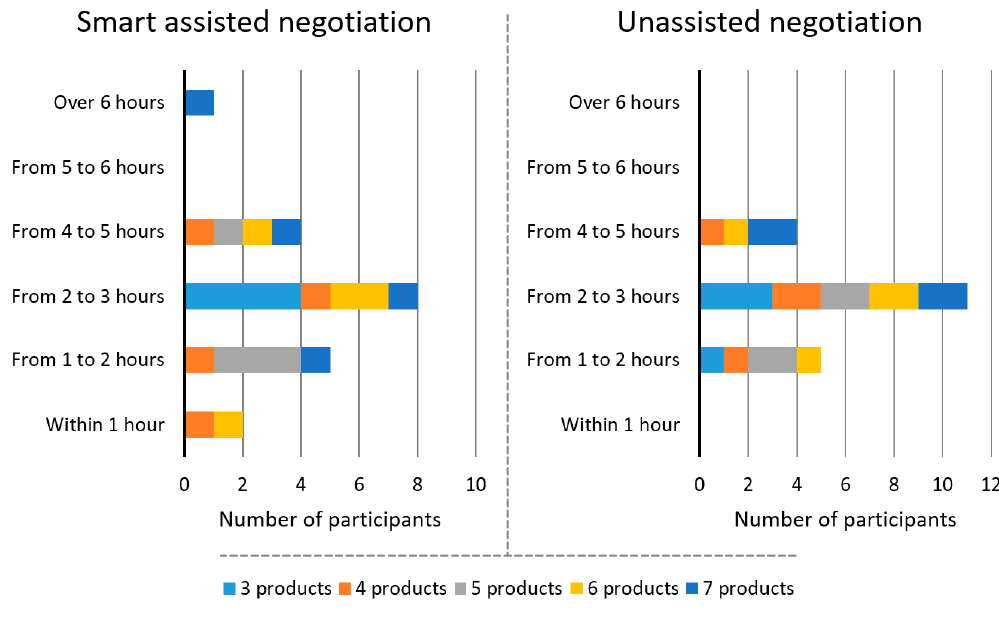
Figure 4. Total net time devoted to the case study.